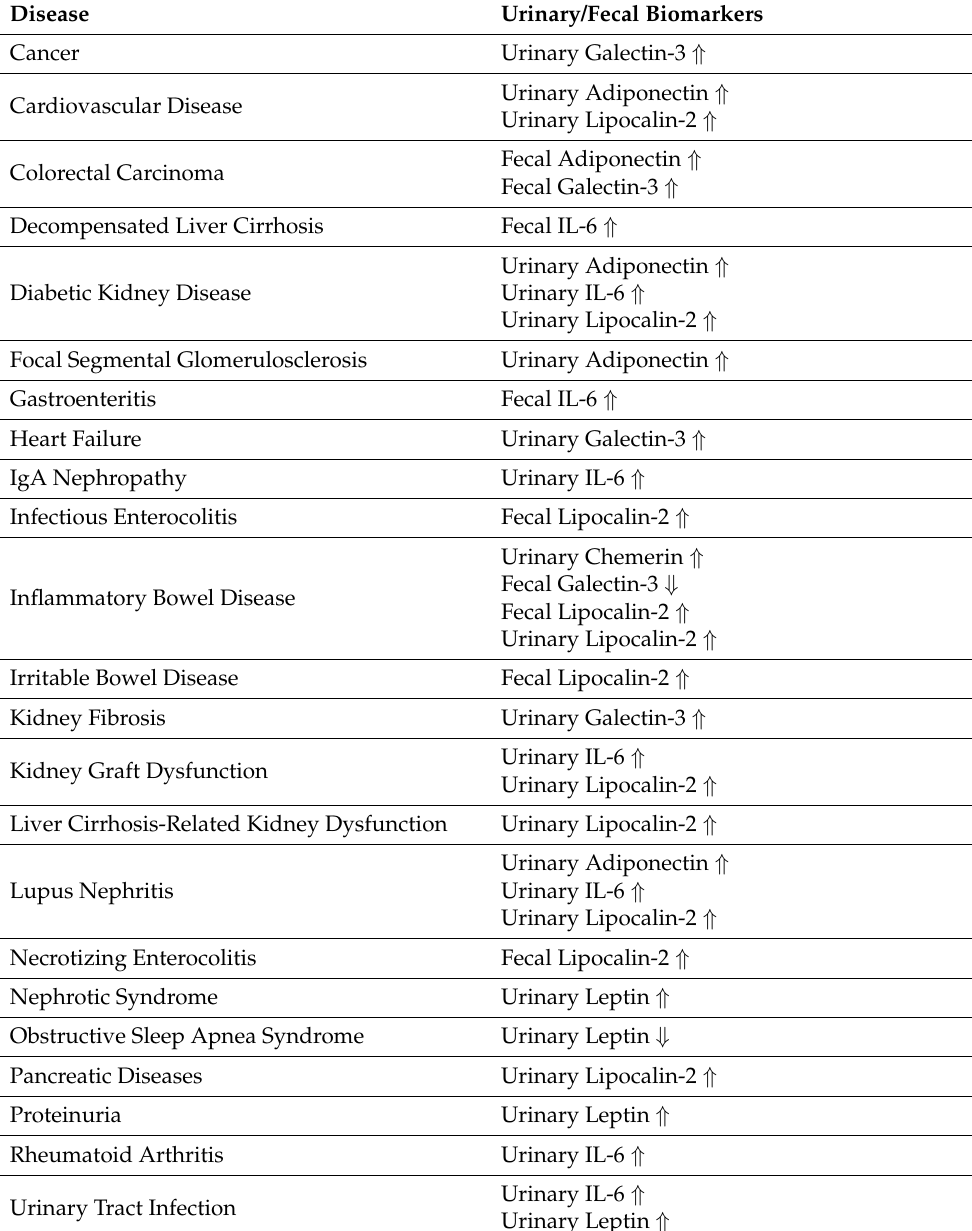
Table 1. Urine and/or feces levels of adiponectin, chemerin, galectin-3, IL-6, leptin and lipocalin-2 have potential to serve as biomarkers for the diseases listed in the left column. Elevated ( ⇑ ) and reduced ( ⇓ ) levels in urine or feces in patients compared to the respective controls are listed in the right column. Diseases as well as adipokines are listed in alphabetical